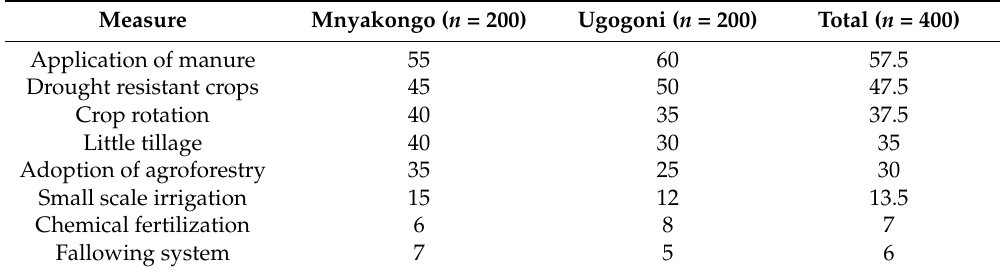
Table 8. Strategies Adopted by the Local People to Improve Livelihoods and